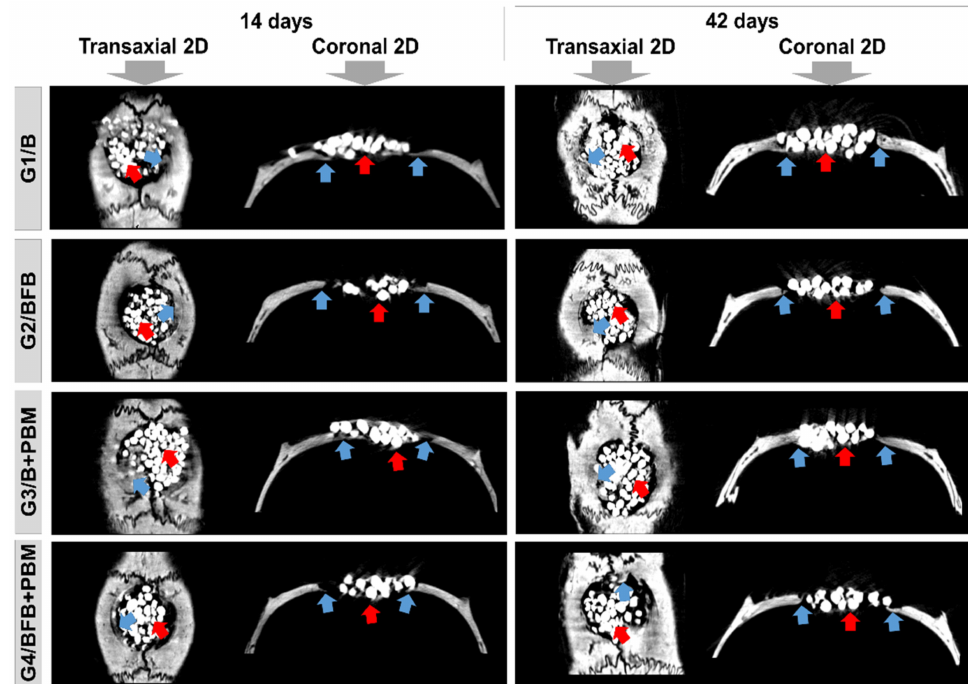
Figure 5. Two-dimensional (2D) reconstructed microtomographic images in transaxial and coronal sections of the bone defects in rat calvaria at 14 and 42 days, respectively. Defect filled with bioma- terial (G1/B), biocomplex consisting of biomaterial plus heterologous fibrin biopolymer (G2/BFB), biomaterial and PBM (G3/B + PBM), and biocomplex consisting of biomaterial plus heterologous fibrin biopolymer and photobiomodulation with low-level laser therapy (G4/BFB + PBM). Bone formation (blue arrow) and biomaterial particles (red